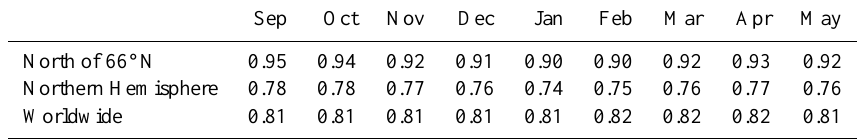
Table 2. Ratios of wet deposition to wet plus dry deposition in the GISS model from September to May